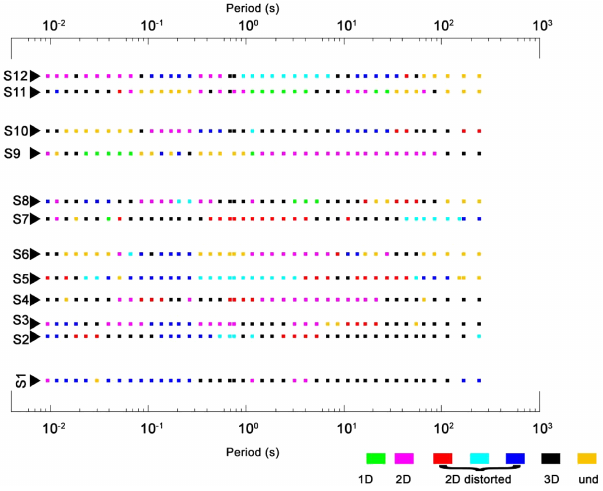
Figure 2. Dimensionality cases for all soundings at each